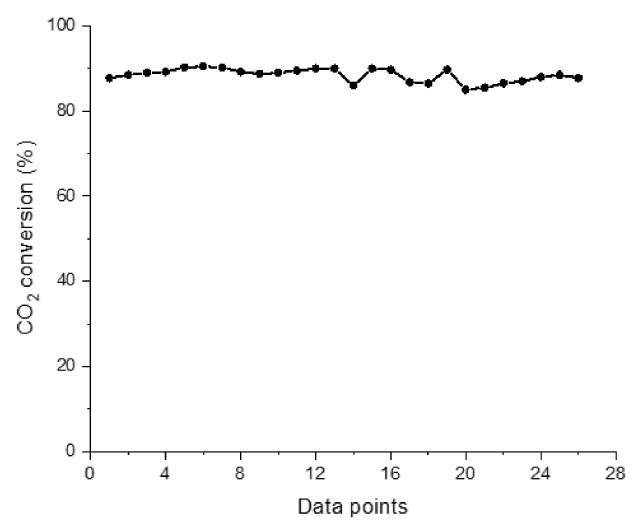
Figure 4. CO 2 conversion from raw, cleaned biogas at 350–500 ◦ C, 8 bar using CH 4 :CO 2 :H 2 = 23.1:15.4:61.5.